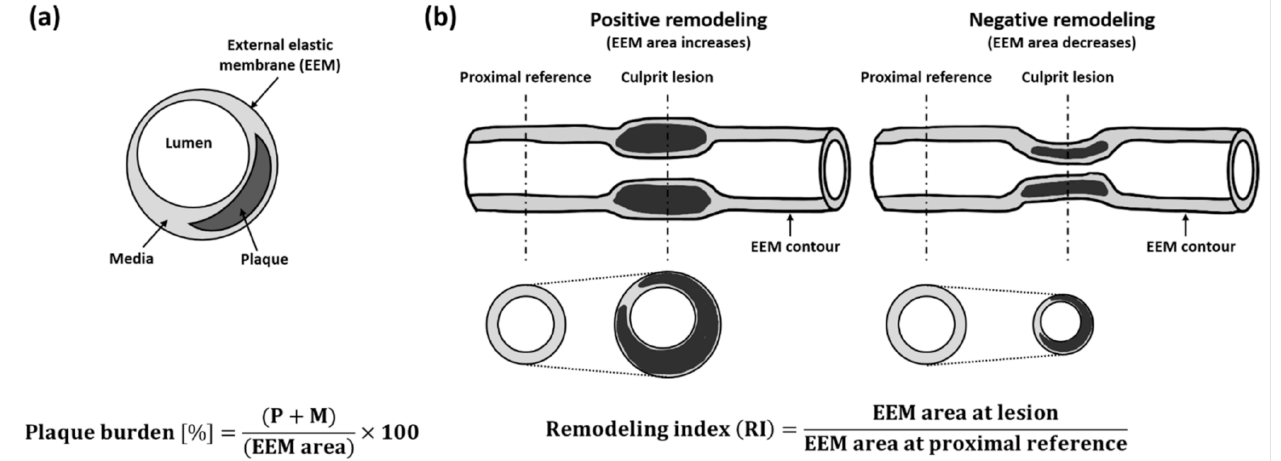
Figure 2. Measurements of ( a ) plaque burden and ( b ) remodeling index (RI). P and M are areas of plaque and media, respectively, and EEM indicates the external elastic membrane. P + M is also equal to EEM area–lumen area [37,51].